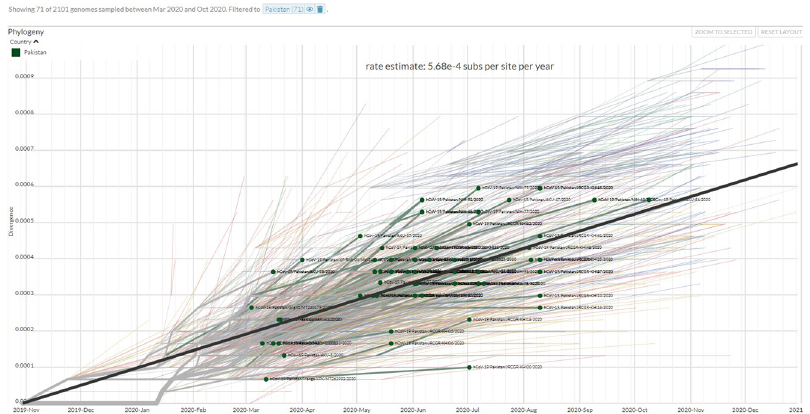
Fig 3. Estimation of divergence in Pakistani SARS-CoV-2 strains over time. Isolates from Pakistan were matched with a sub-sample from Asian over time. The graph shows an estimate of divergence within genomes over the time period.